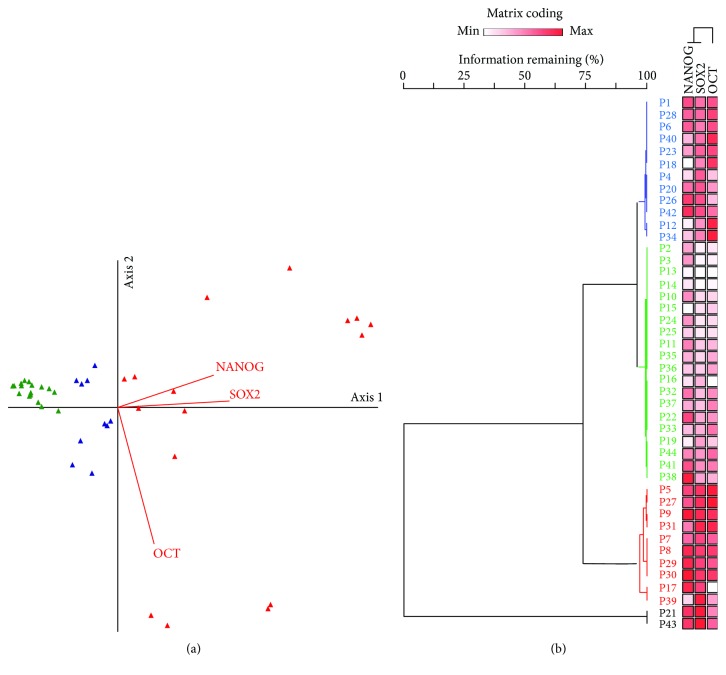
Multivariate analyses cluster GBM patients according to transcriptomic signature. PC-ORD v5.0 was used for exploratory multivariate analysis. Data set was profiled by the program. There was no need for transformation as beta diversity was zero and there was no outlier. (a) Ordination graph by PCO and (b) two-way hierarchical cluster analysis. The following parameters were adjusted: linkage method; Ward's method; distance method; Euclidean method; relativizing matrix by column maximum; and matrix coding percentile by column. Percent chaining = 7.38. Clustering identified three patient groups according to their gene expression. The red clade for overexpression of the three pluripotent genes, the green clade discriminates patients with gene downregulation, and the blue clade has variable degrees of expression. Two samples (black clade) were out-group from the other clusters.